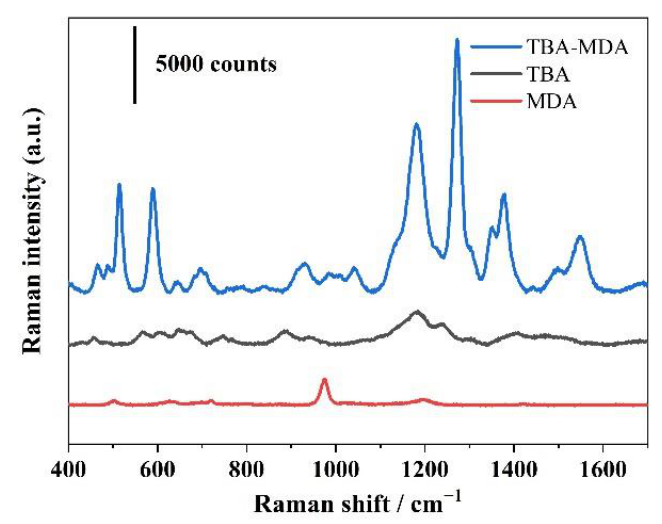
Figure 3. SERS spectra of 20 mM of MDA, 7 mM of TBA and 0.1 µ M of TBA-MDA in the reaction mixture.